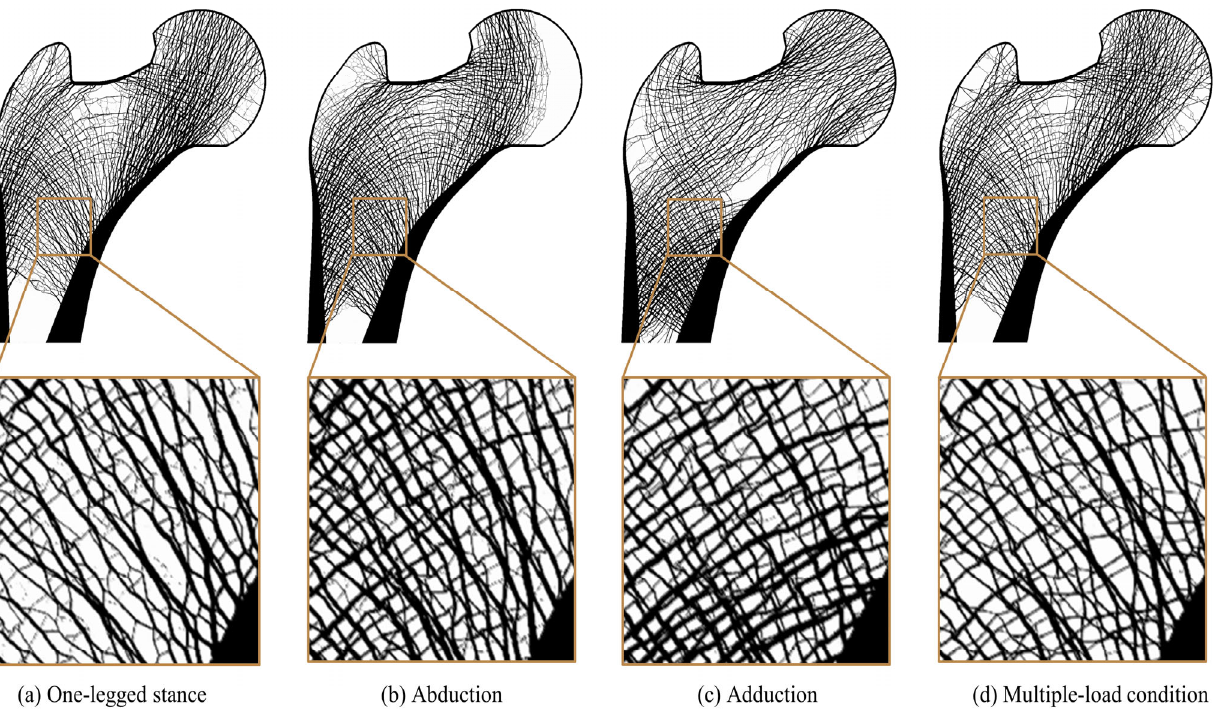
Figure 8. Morphological change in trabecular architecture of proximal femur for ( a – c ) single ‐ loading conditions and ( d ) multiple ‐ loading condition.